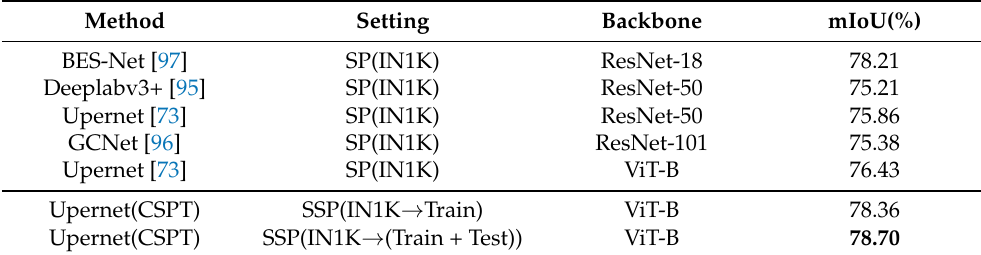
Table 7. The comparison results on ISPRS POTSDAM [21]. The best results are marked in bold. Method Setting Backbone